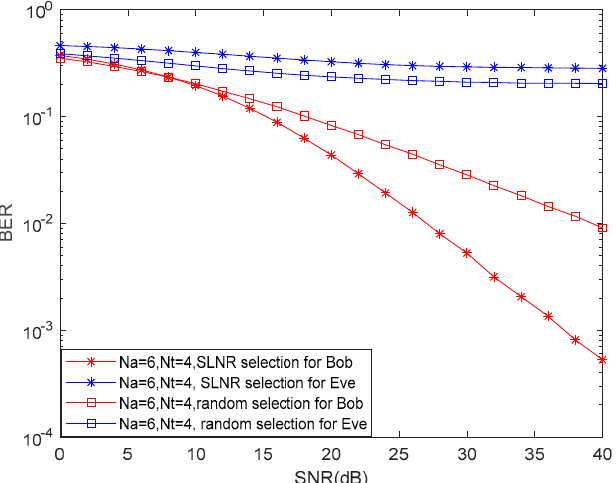
Figure 4. BER over SNR under different schemes for different schemes .